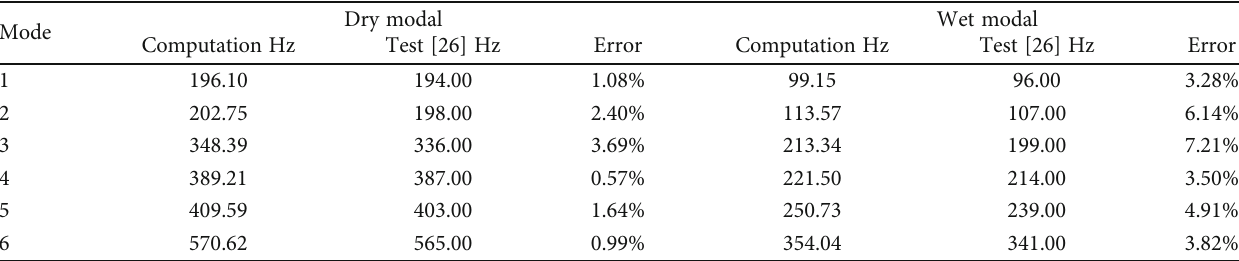
Table 1: Natural frequencies of the